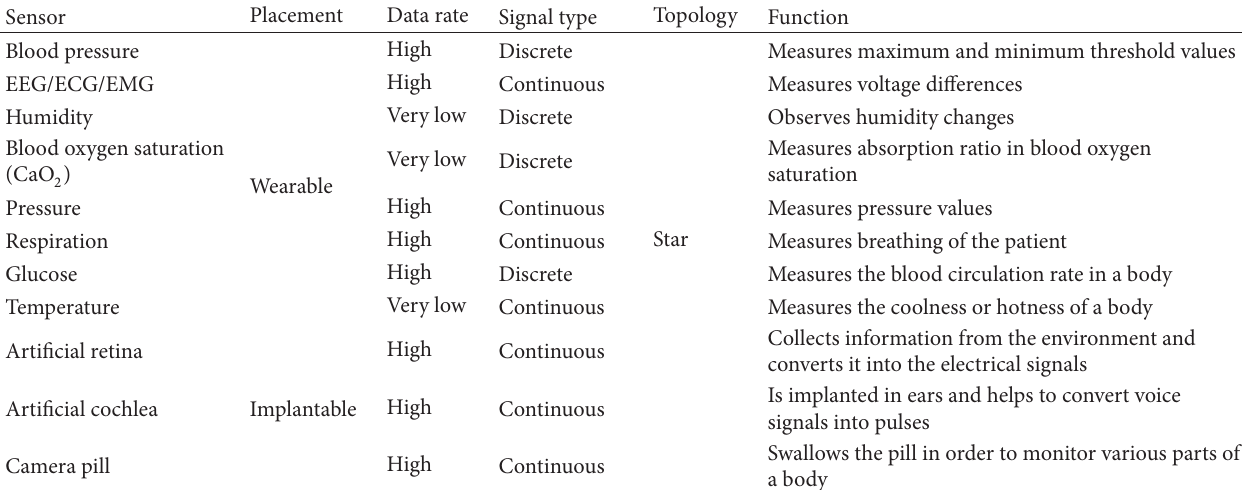
Table 1: BMSs functionalities in WBAN [19, 20].